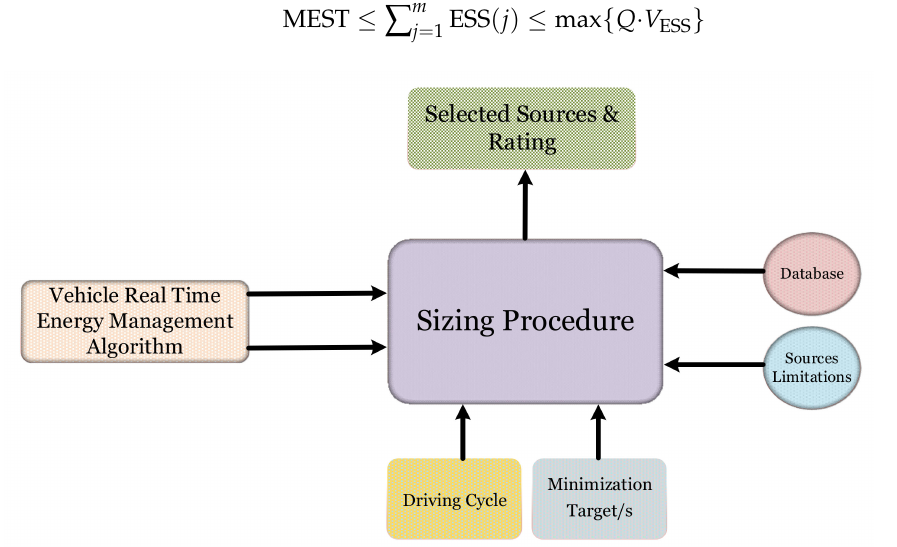
Figure 11. Sizing